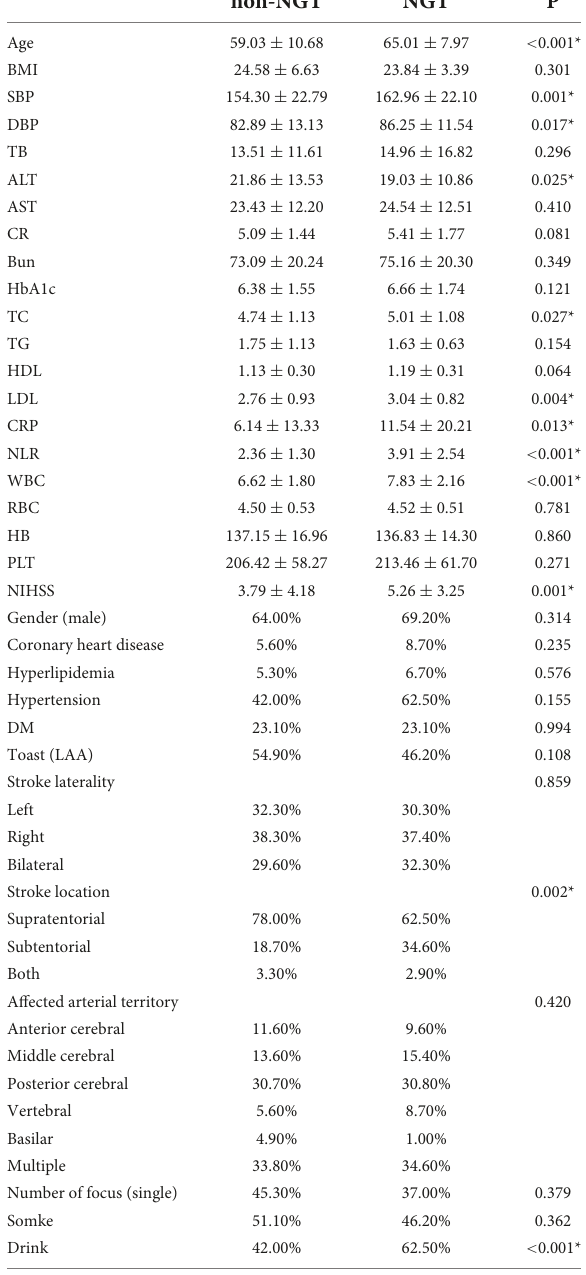
TABLE 1 Clinical baseline characteristics of the development